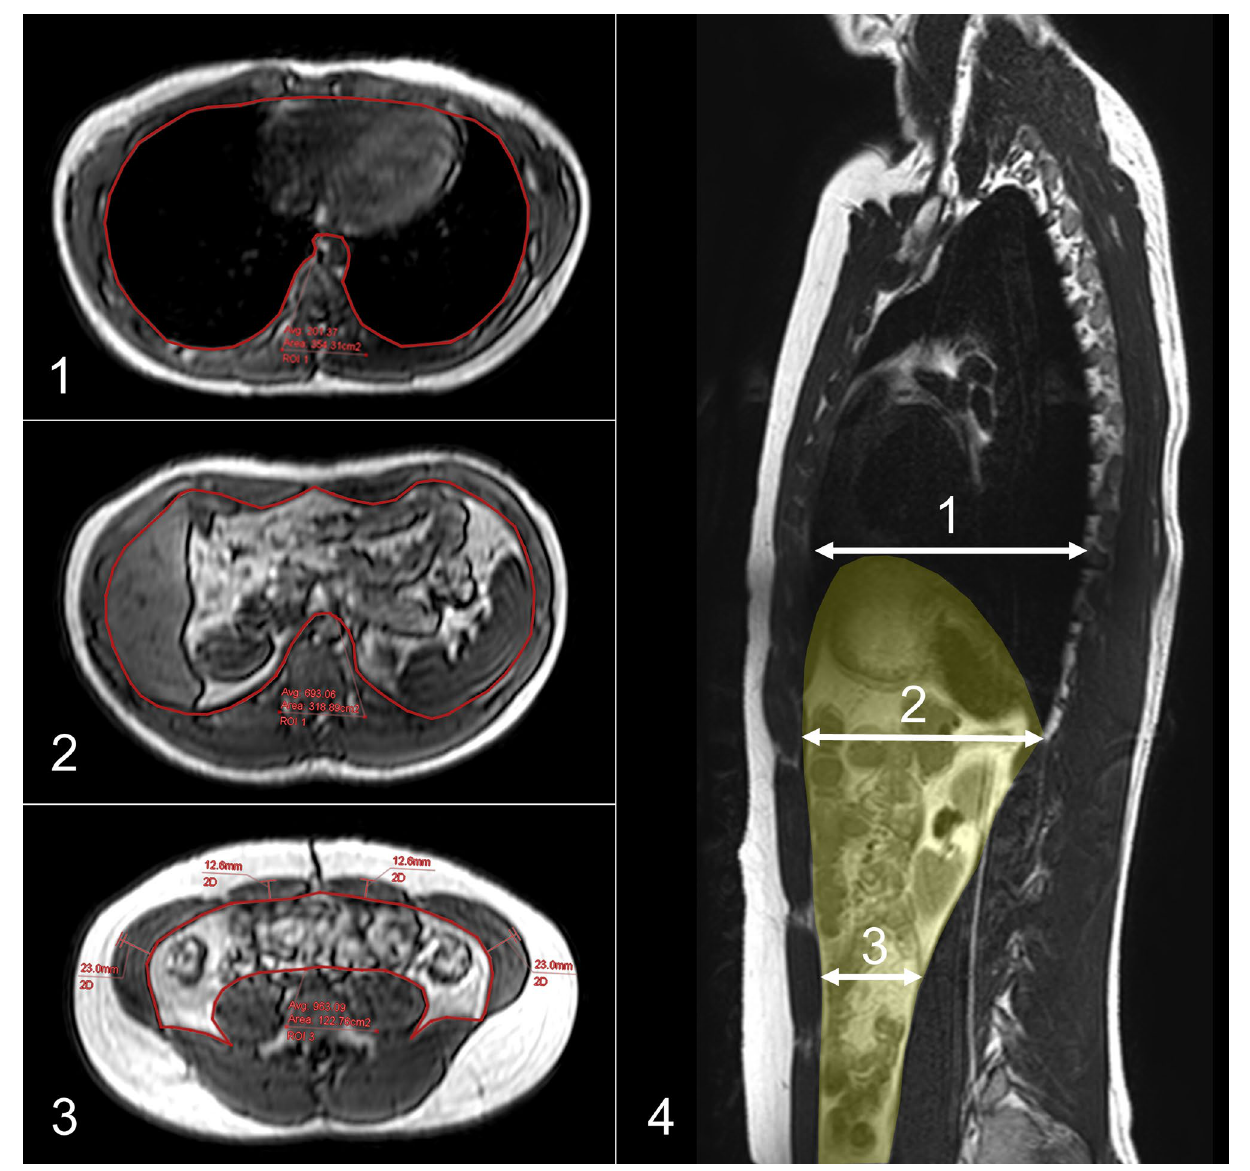
Figure 2. Measurements of the cross-sectional area of the abdominal cavity at three levels. 1 Axial MR image at the upper liver level showing measurements of cross-sectional area. 2 Axial MR image at the lower lung level showing measurements of cross-sectional area. 3 Axial MR image at the umbilical level showing measurements of cross-sectional area and thickness of the abdominal muscles. 4 Sagittal MR image at the left kidney level showing abdominal cavity, which is marked in yellow. (1) indicates the upper liver level, (2) indicates the lower lung level, and (3) indicates the umbilical